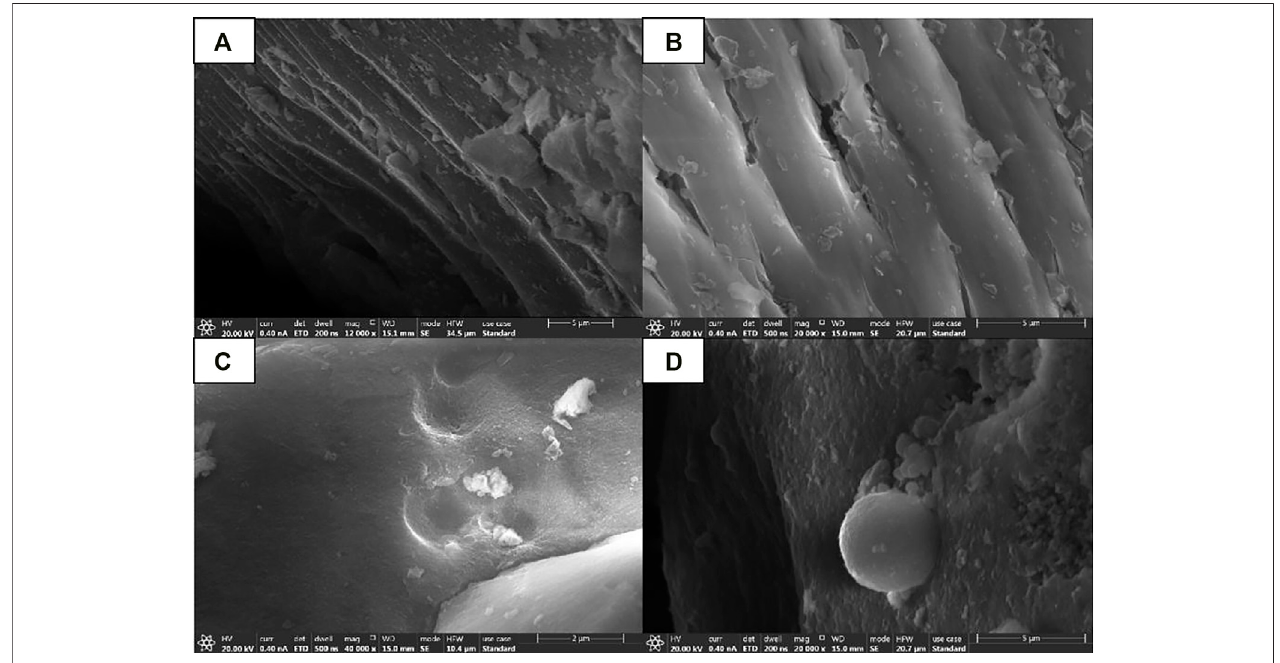
FIGURE 15 | SEM patterns of mineral polymer precursors synthesized with different amounts of ethanol. (A) RE=0.5 ; (B) RE=1 ; (C) RE=2 ; (D) RE=3.